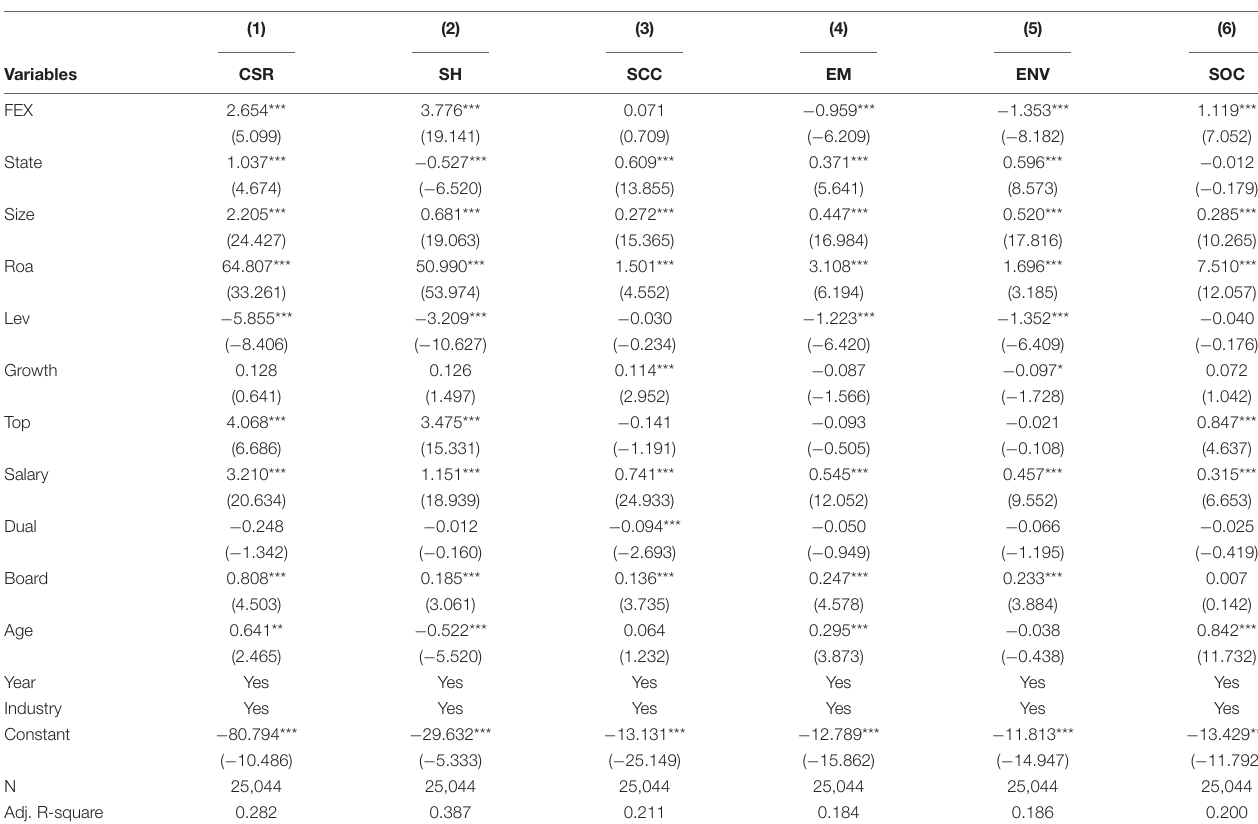
TABLE 3 | The impact of financial redundancy on